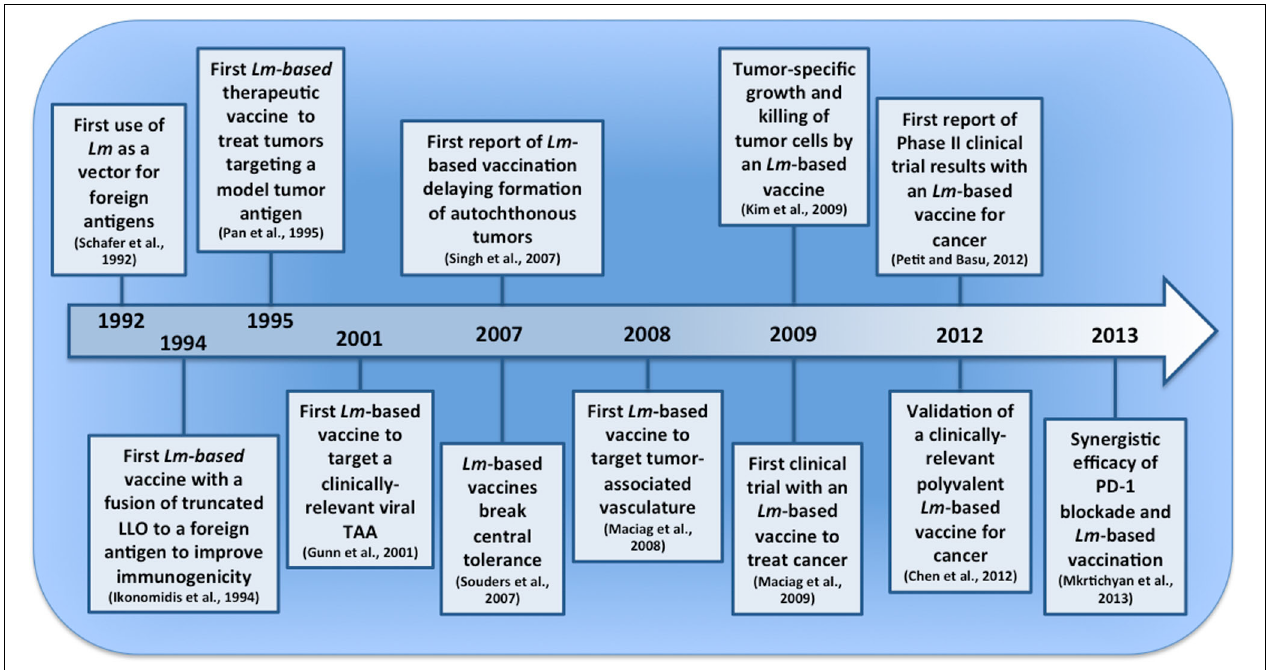
FIGURE 1 | Pivotal events in the development of Lm -based vaccines for tumor immunotherapy. The last two decades have seen the emergence of Lm -based vaccines and their first clinical application for cancer. In this